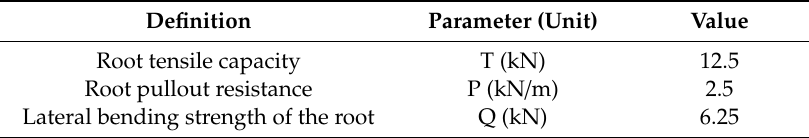
Table 9. Root properties for modeling of soil–root interactions